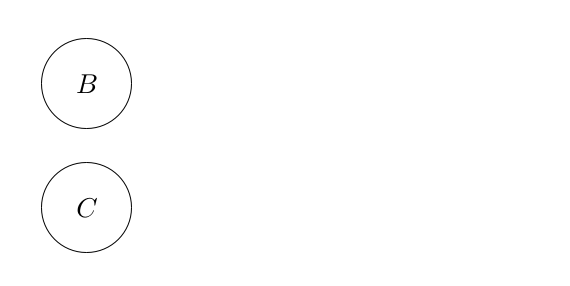
Figure 21 . Schematic representation of a tree amplitude with at least two disconnected com- ponents. The blobs B and C represent tree amplitudes which themselves may have additional disconnected components.